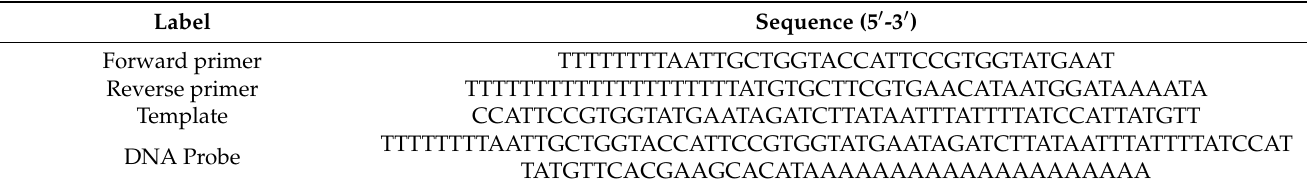
Table 1. The sequence of primers with adapters, template, and DNA